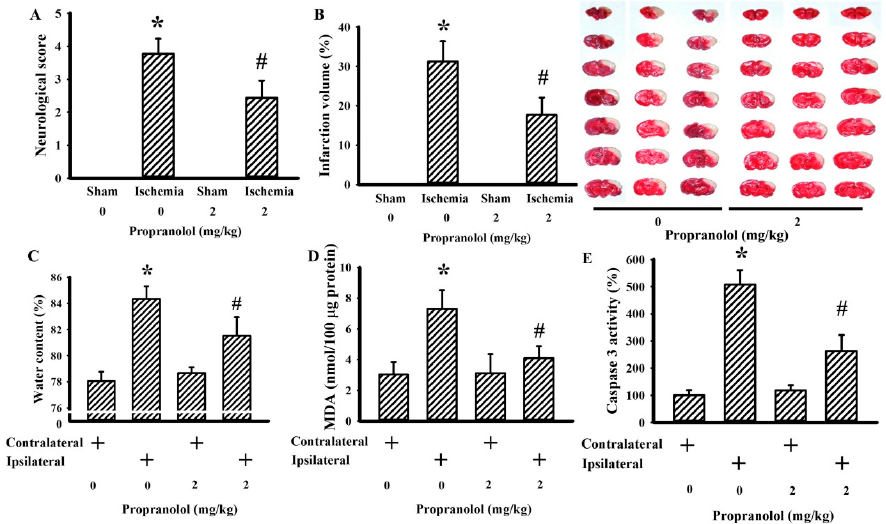
Figure 2. Propranolol protected against cerebral ischemia injury. Rats receiving a normal saline vehicle or a propranolol (2 mg/kg) intraperitoneal injection were subjected to sham or permanent cerebral ischemia for 24 h. ( A ) Neurological deficits were evaluated by neurological score. ( B ) Representative photographs show the histological examination of a brain infarction by triphenyltetrazolium chloride (TTC) staining. The average percentage of infarction volume in the ipsilateral hemisphere is depicted. ( C ) The water content in the contralateral and ipsilateral cortical tissues was measured. ( D ) The contents of malondialdehyde (MDA) in the contralateral and ipsilateral cortical tissues were measured. ( E ) Proteins were extracted from the contralateral and ipsilateral cortical tissues and subjected to an enzymatic assay of caspase 3 activity. * p < 0.05 vs. sham/saline or the contralateral tissues of the vehicle groups and # p < 0.05 vs. ischemia/saline or the ipsilateral tissues of the vehicle groups, n = 6.